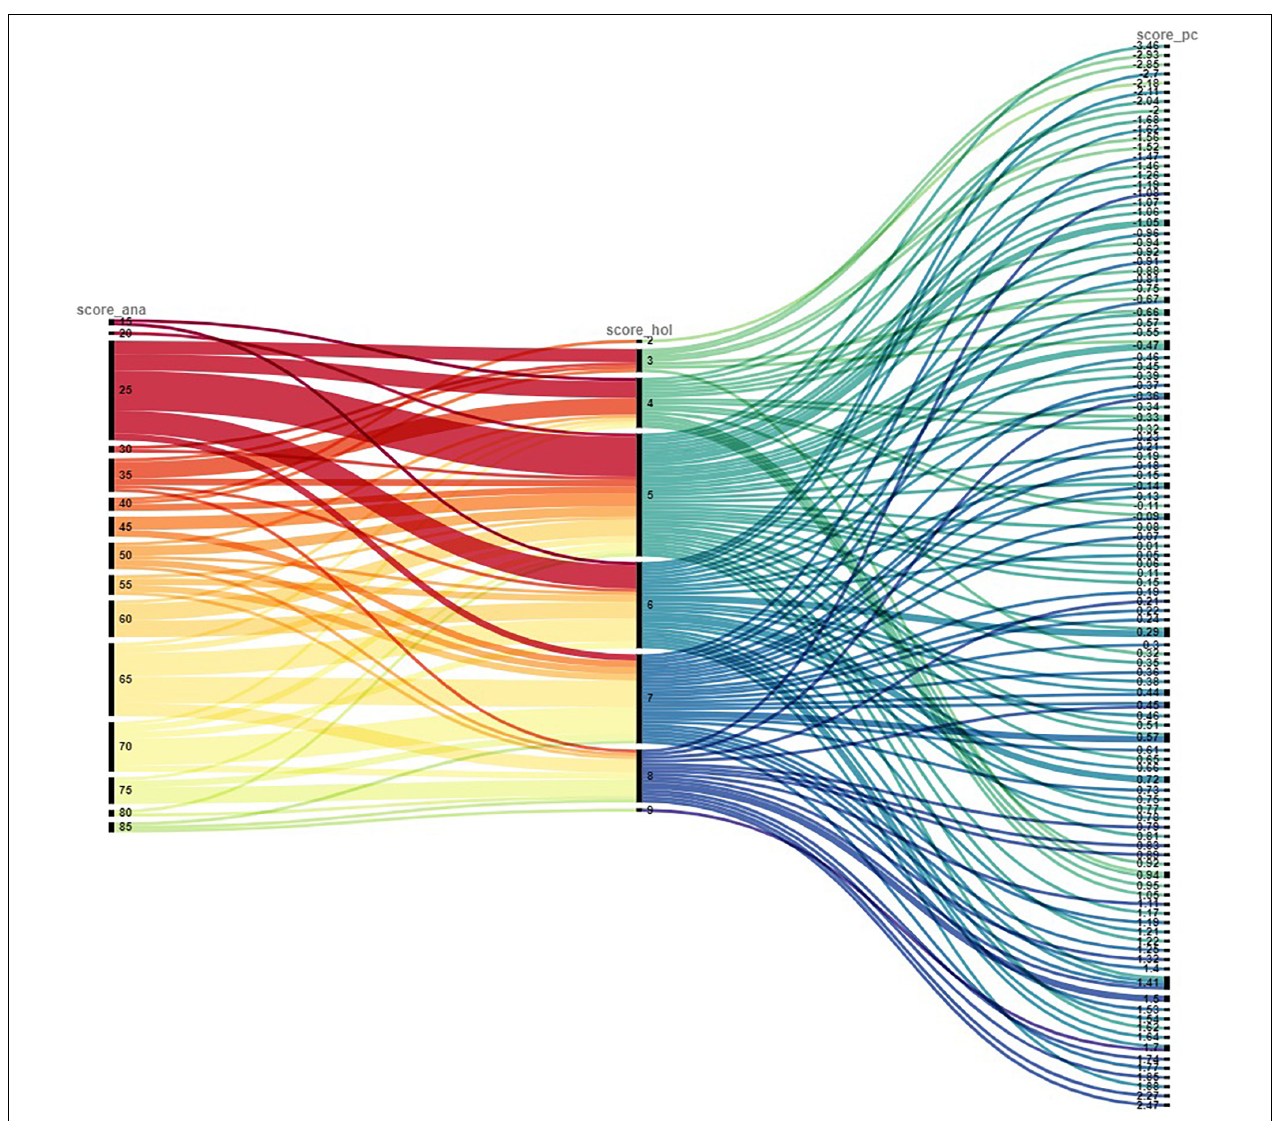
FIGURE 1 | Alluvial plot presenting the comparison of scores assigned through different rating procedures. Each colored line represents an argumentative text. The Figure shows a combination of the three procedures, with the analytic score on the left, the holistic score in the middle, and the pairwise comparisons score on the right. The scores per rating procedure are ordered from low (top of the alluvial plot) to high (bottom of the alluvial plot). Lines that are situated at the bottom of the figure represent a low score. Lines at the top of the figure represent a high score. The numbers on the vertical axes represent the scores attained by the rating procedure. Texts do not systematically score high or low on all three procedures, as becomes clear when looking at the